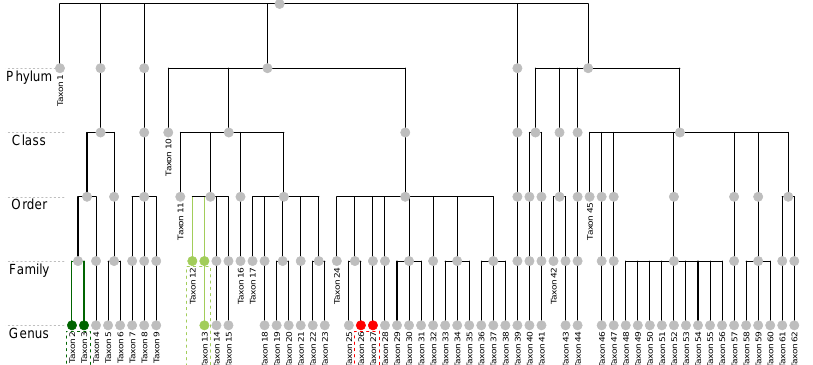
Figure 2. The NICU data: Taxonomic structure of the 62 taxa at the genus level. Taxon 2 and Taxon 3 (dark green nodes) share the same parent and are at the same taxonomic rank. Taxon 12 and Taxon 13 (light green nodes) are at different ranks but they share the same lowest multi-child ancestor. Taxon 26 and Taxon 27 (red nodes) do not share the same lowest multi-child